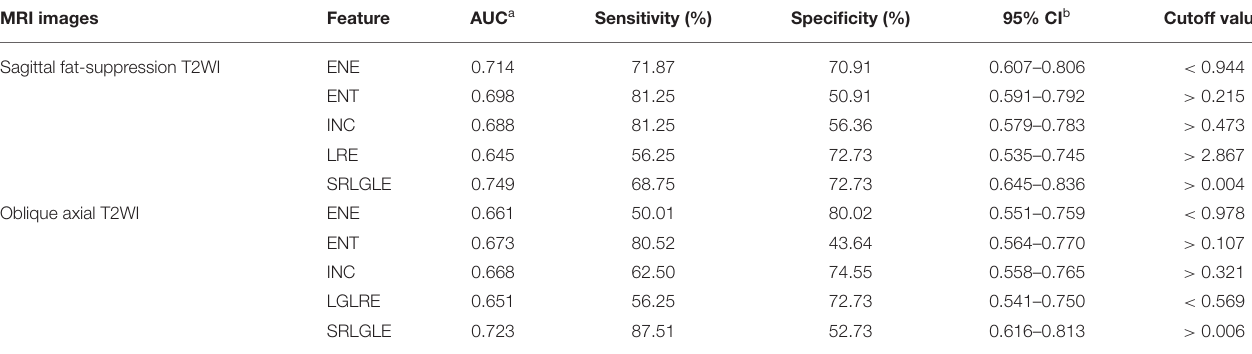
TABLE 4 | Diagnostic performance of statistically significant texture features for differentiating stage N0 and N1-2 tumors.